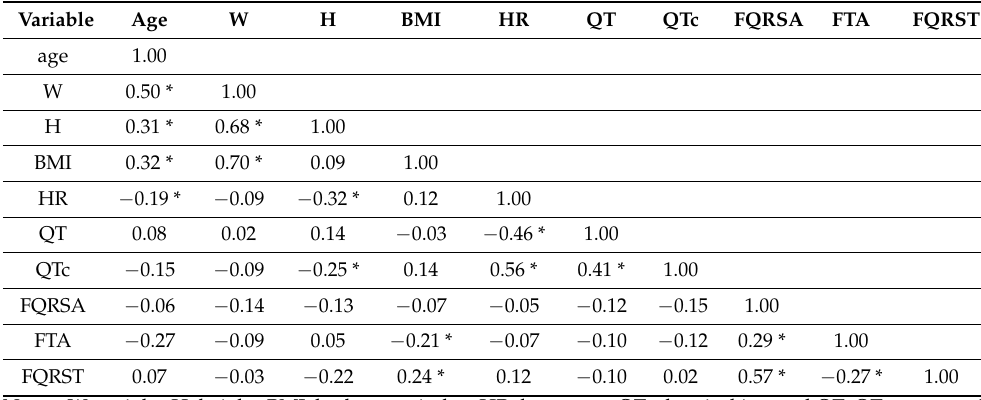
Table 6. Correlation output (Spearman’s correlation coefficient r s ) between the recorded variables and the statistical significance level “ p ” ( n =